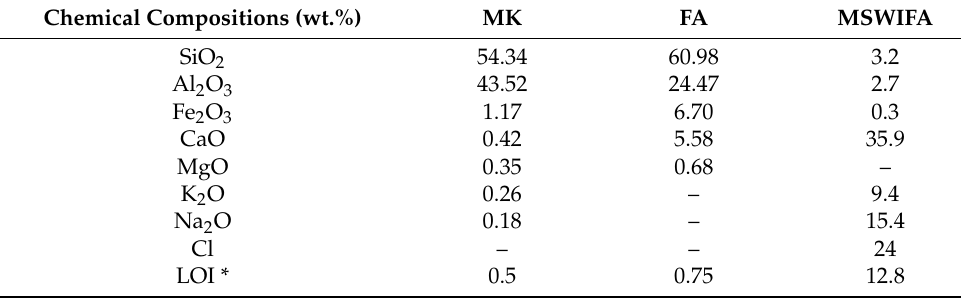
Table 1. Chemical compositions of MK, FA, and MSWIFA. Chemical Compositions